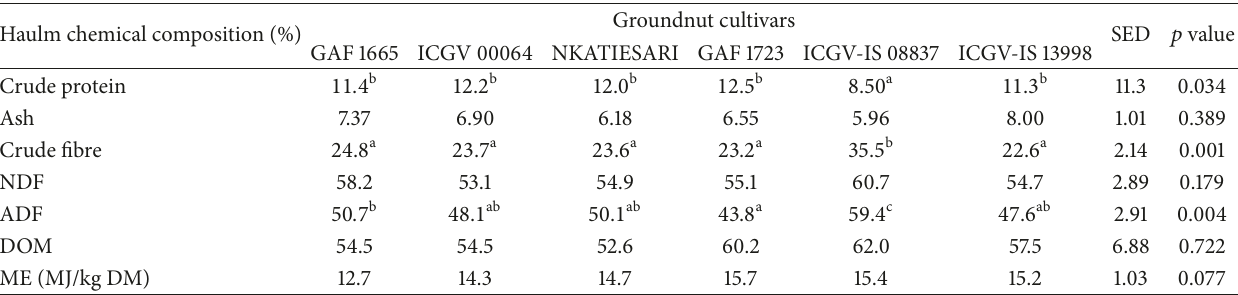
SED = standard errors of differences of means. Table 6: Chemical composition of dual purpose cultivars of groundnut haulms. Haulm chemical composition